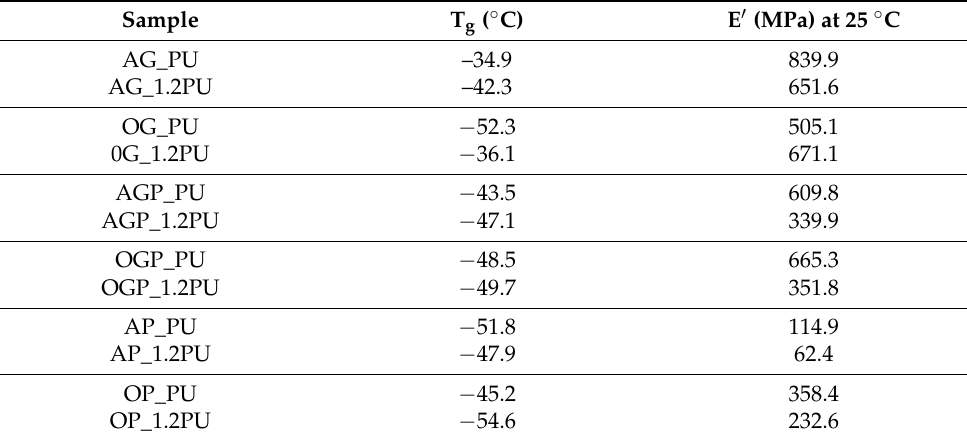
Table 6. Dynamic mechanical and thermal properties of polyurethane